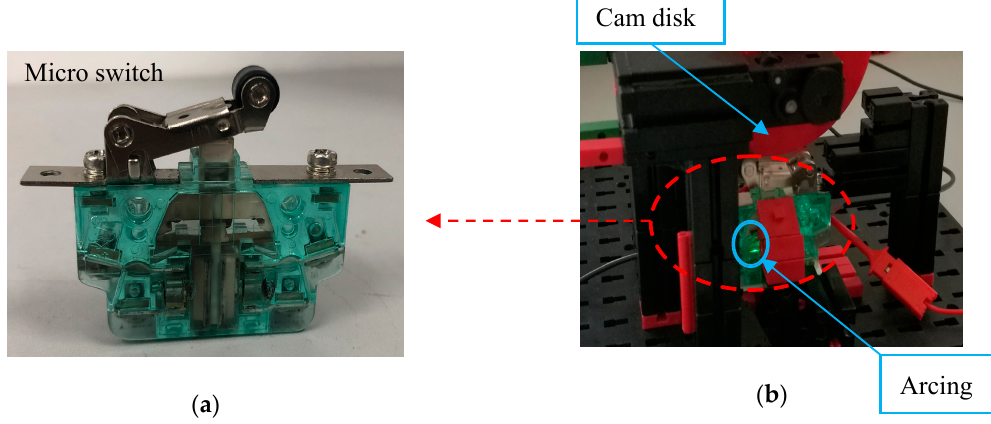
Figure 2. The working period of the typical drive controller micro-switch (S826).